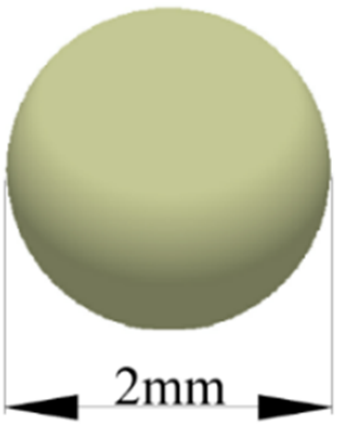
Figure 6. Soil particle model.